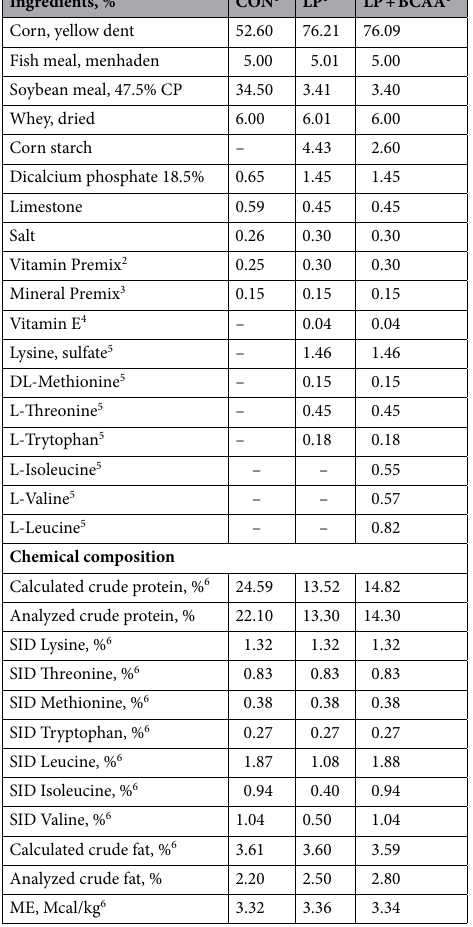
Table 2. Composition of experimental diets (as-fed basis). 1 CON, control diet; LP, low protein diet; LP + BCAA, low protein diet supplemented with branched-chain amino acids. 2 Vitamin Premix: vitamin A, 1,650,000 IU/kg; vitamin D3, 660,000 IU/kg; vitamin E, 17,600 IU/kg; menadione, 1,320 mg/kg; vitamin